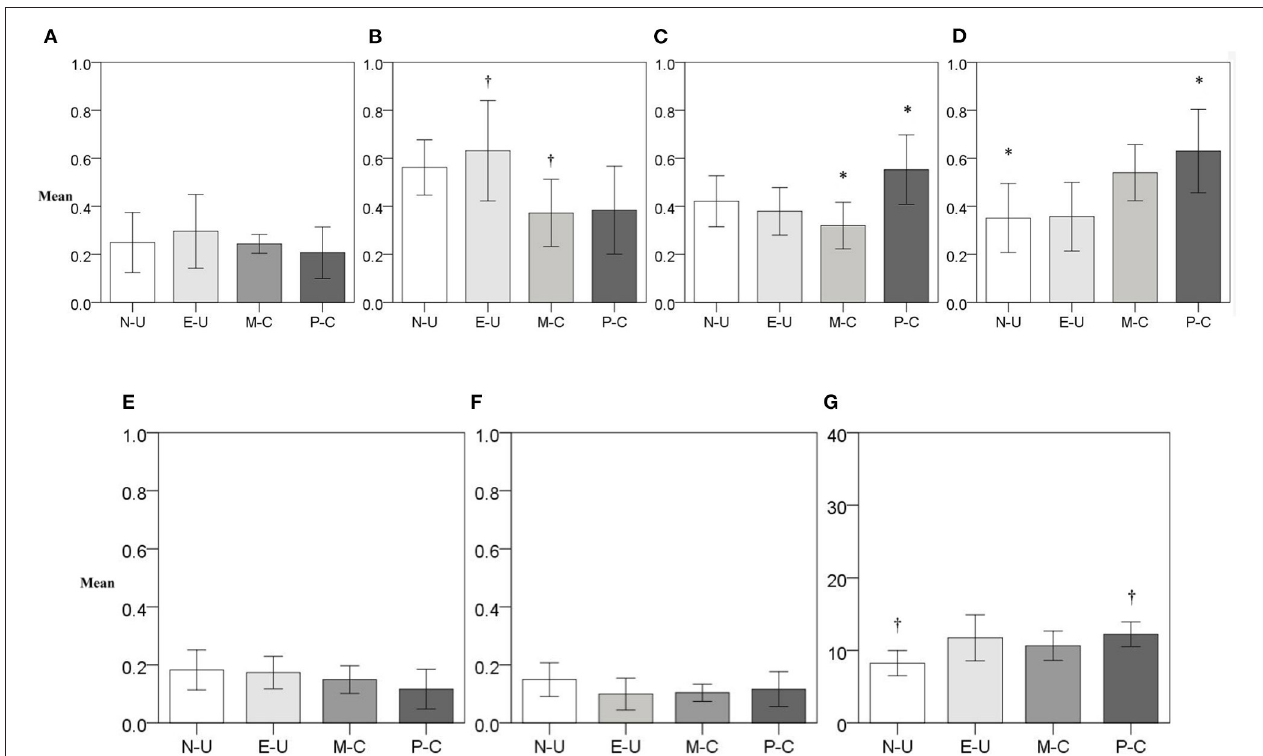
FIGURE 1 | Predictor variables mean by type of drug involvement. (A) Delay Gain (Discounting Task), (B) Delay Loss (Discounting Task), (C) Probabilistic Gain (Discounting Task), (D) Probabilistic Loss (Discounting Task), (E) Perseverative Errors (CST), (F) Deferred Perseveration (CST), and (G) Antisocial Traits (APSD). N-U, non-use; E-U, experimental use; M-C, moderate-use; P-C, problematic use; CST, card sorting test; APSD, antisocial process screening device. † p > 0.0 5. * p < 0.0 5.